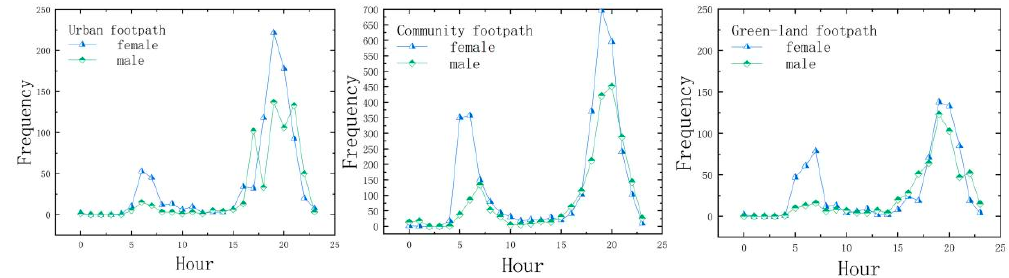
Figure 5. Twenty-four hours of jogging of different gender groups on each footpath.